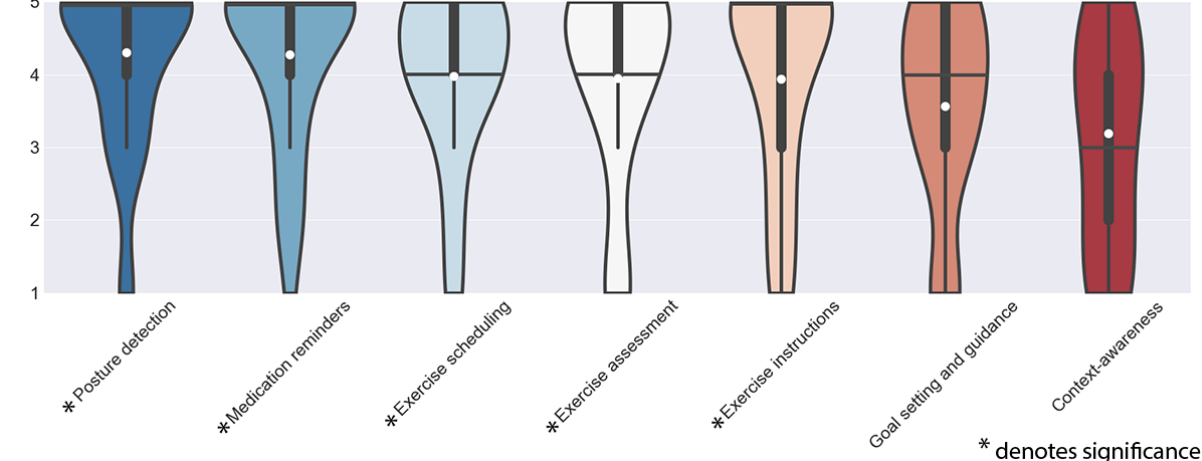
Medication reminders (μ